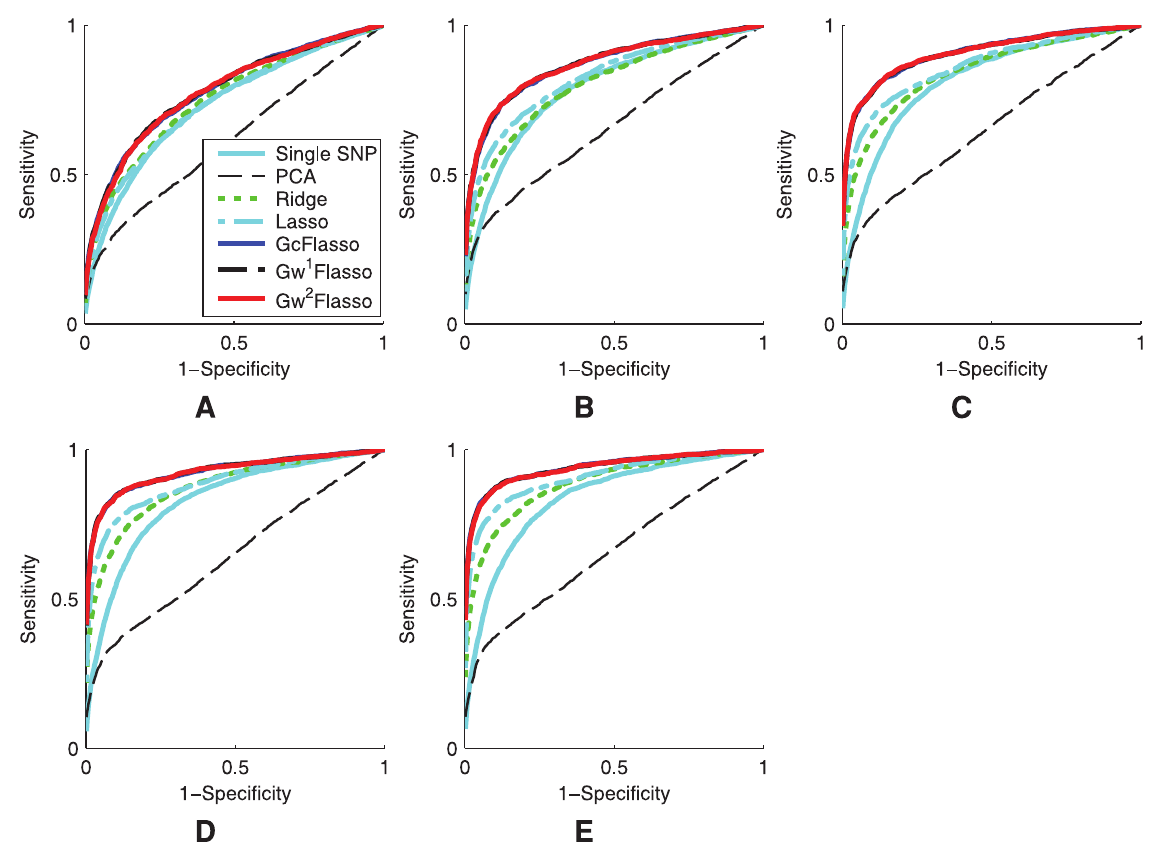
Figure 5. ROC curves comparing the performance of association analysis methods when the sample size varies. Panels show (A) N ~ 50 , (B) N ~ 100 , (C) N ~ 150 , (D) N ~ 200 , and (E) N ~ 250 . The association strength was 0.5, and the threshold r for producing the QTN was set to 0.3. The results were averaged over 50 simulated datasets. The ROC curves for G c Flasso , G 1